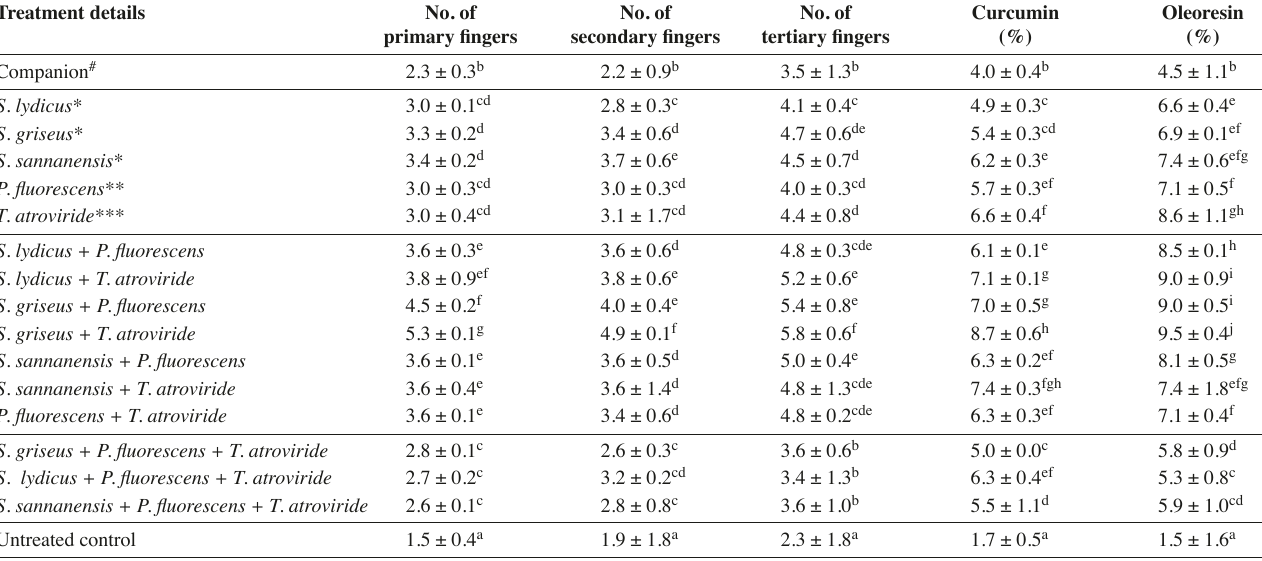
Tab. 3: Effect of various biocontrol agents and fungicide on quality characteristics of turmeric rhizomes Treatment